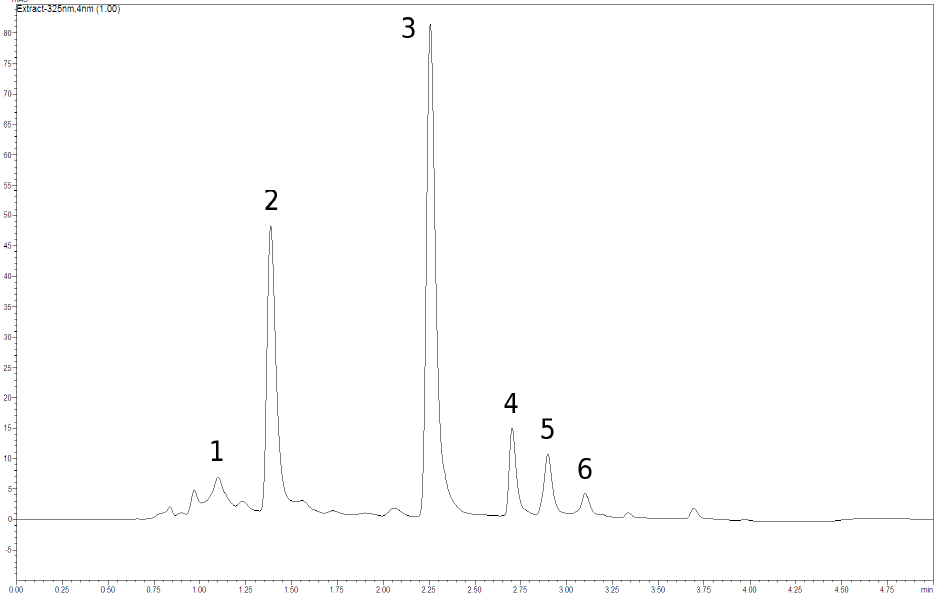
Figure 2. HPLC chromatogram of the nettle leaf methanolic extract: ( 1 ) neochlorogenic acid, ( 2 )